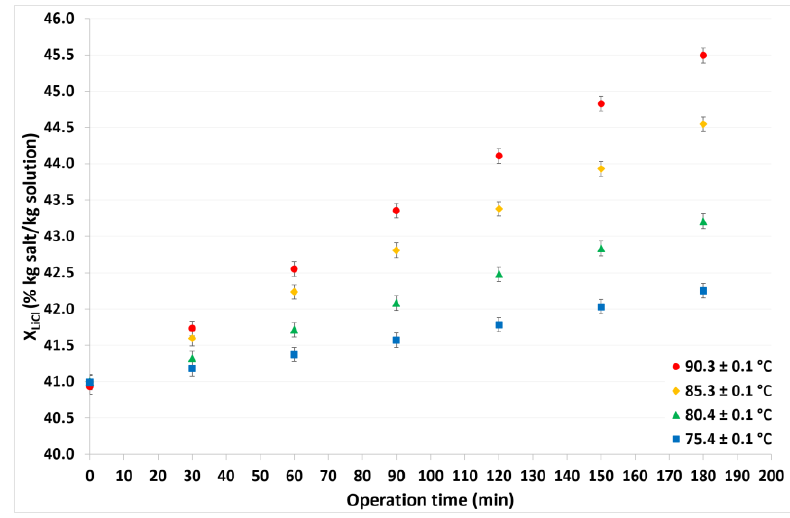
Figure 8. LiCl concentration as a function of operation time.